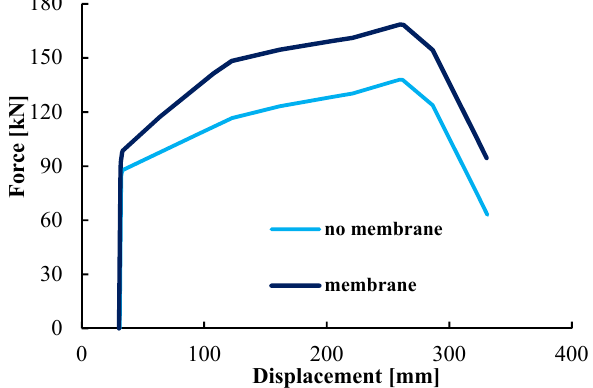
Figure 10. Membrane forces above column 5 in RC beam–column substructures under push- down